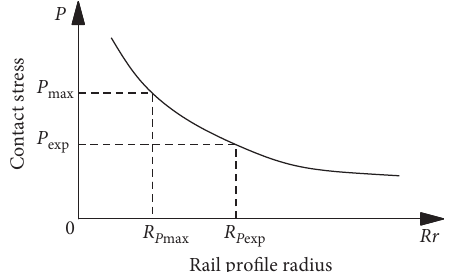
Figure 7: Schematic of relationship between contact stress and radius in rail profile